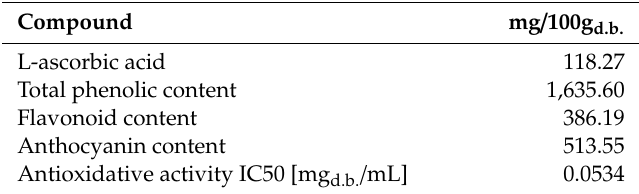
Table 3. The content of BACs and radical scavenging capacityin fresh raspberry